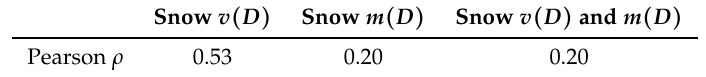
Figure 7. Recalculating R and D m for rain using measured snowfall relationships. ( a ) Difference in the normalized counts between the new calculation of R and D m using the measured snowfall velocity relationship (shown in Figure 6a) and the original calculation (same as Figure 3a). ( b ) Same as ( a ), but with R and D m calculated with the measured snow mass relation (shown in Figure 6b). Table 6. Pearson correlation coefficient between log ( R ) and D m for the experiments in Figure